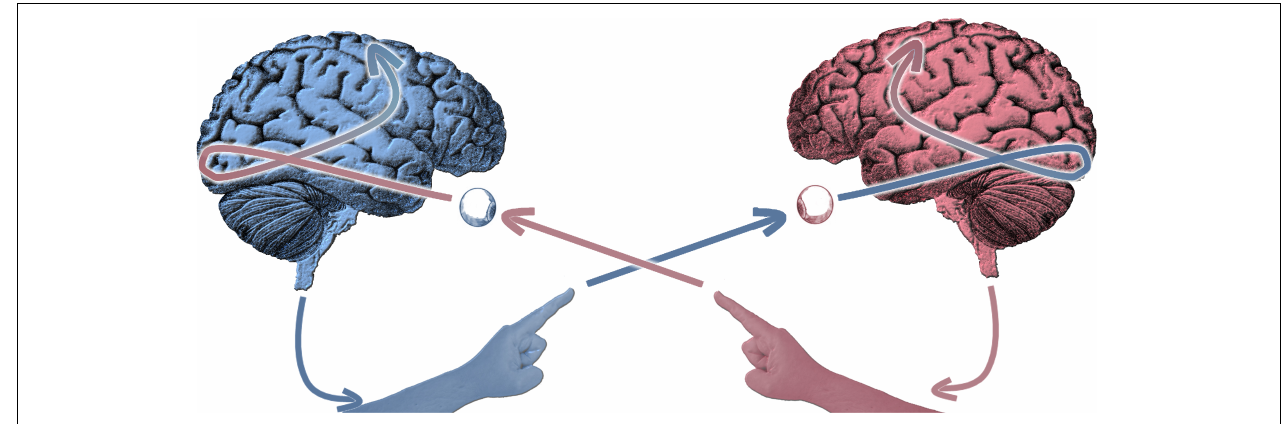
FIGURE 1 | Schematic of the experimental paradigm of social coordination dynamics in which two participants simultaneously perceive and produce behavior in view of each other. More specifically, in our canonical experiment, subjects move their fingers in continuous fashion while at the same time observing their partner doing the same. The paradigm’s simultaneity of dyadic perception and action – bidirectional coupling – is geared toward observing self-organizing processes.